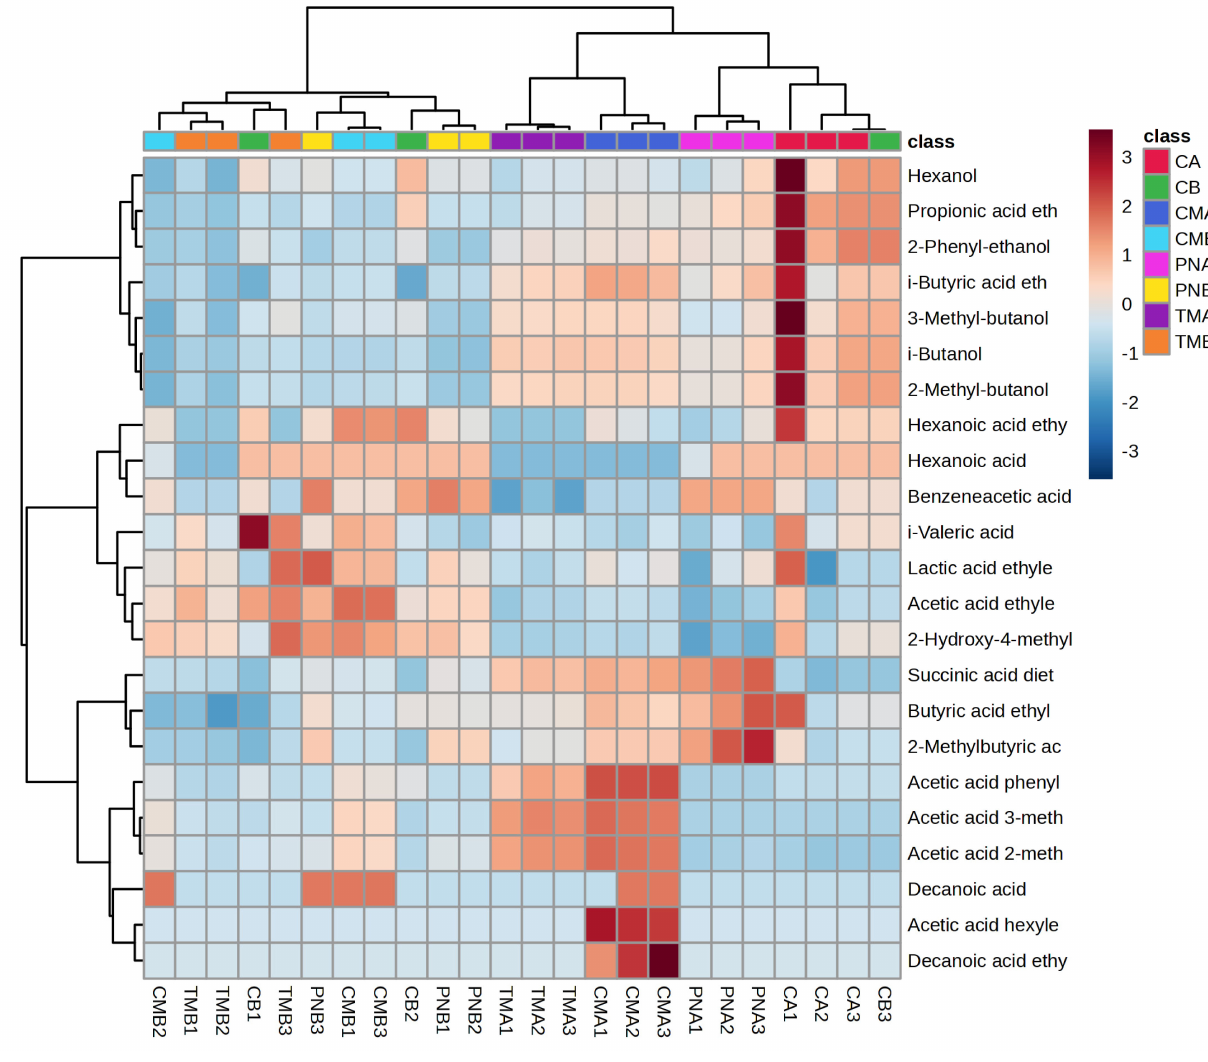
Figure 3. Heat map representing the cider volatile organic compound profile: the darker the colour, the higher the concentration of the compound in the sample. The 6 replicates of each sample are represented. Class A and B are representing the samples of cider produced by T. delbrueckii strain A strain B, respectively. C: base cider; PN: P é t-Nat; TM: Champenoise method, CM: Charmat method. A and B indicate ciders fermented by T. delbrueckii strain A and B,